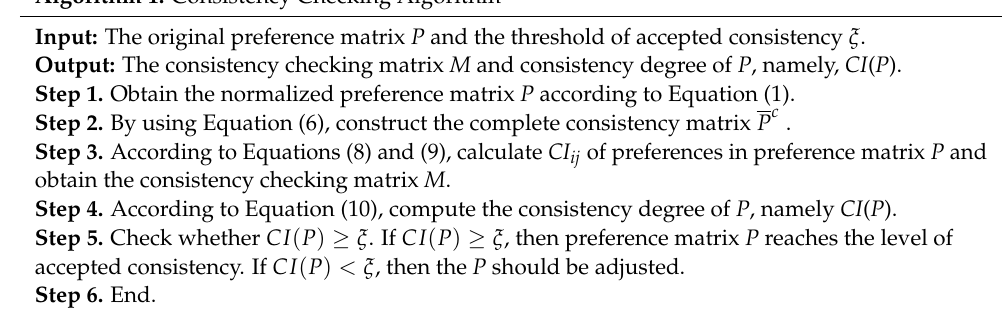
Algorithm 1. Consistency Checking